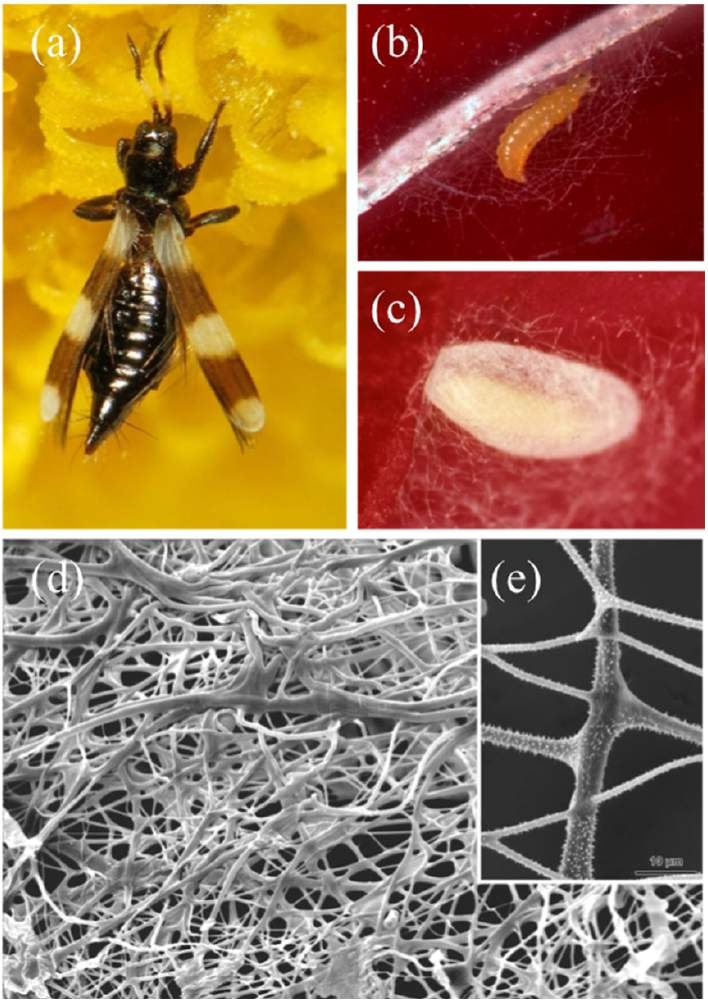
Figure 10. Aeolothrips intermedius Bagnall, 1934. ( a ) female. ( b ) mature larva at the beginning of the spinning procedure. ( c ) cocoon. ( d ) SEM detail of the cocoon fibers with ( e ) a close-up of the spines. From Conti et al. [5].